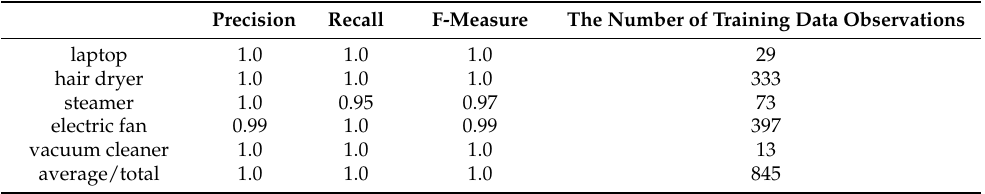
Table 1. Load recognition results obtained by the specified and trained feed-forward ANN in training.